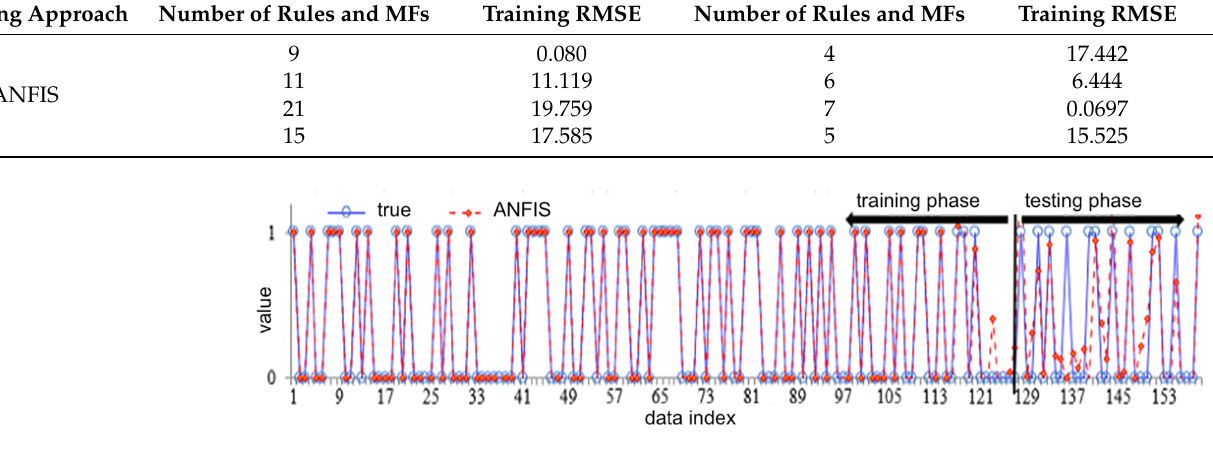
Figure 12. The true data points—blue—versus the training and testing outcomes—red color points and lines—of ANFIS approach; see abbreviations in